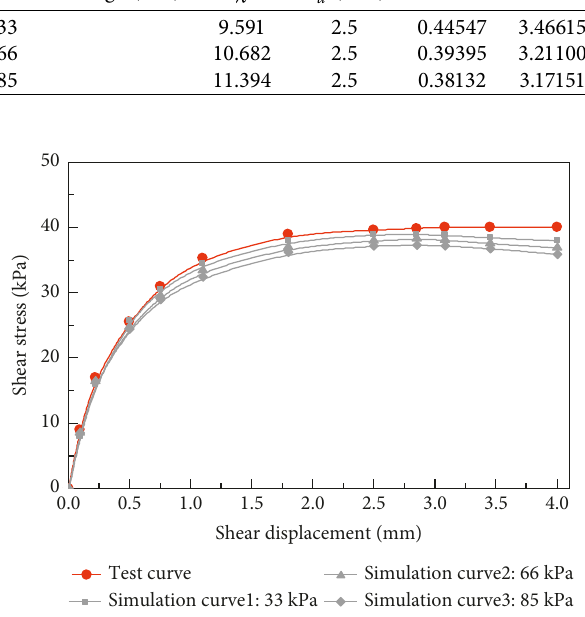
Figure 7: Simulation curves obtained using different interpolation